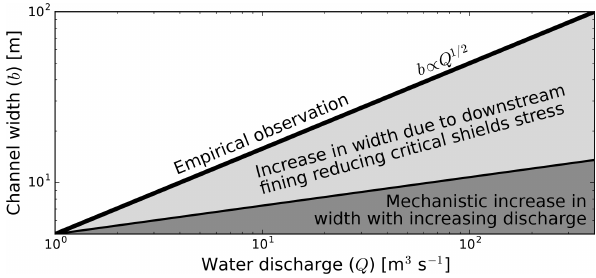
Figure 9. In an equilibrium-width self-formed gravel-bed river channel, the common field observation that river channel width is proportional to the square root of water discharge may be explained by a combination of the direct impact of river discharge on channel width and by downstream fining of bed-material